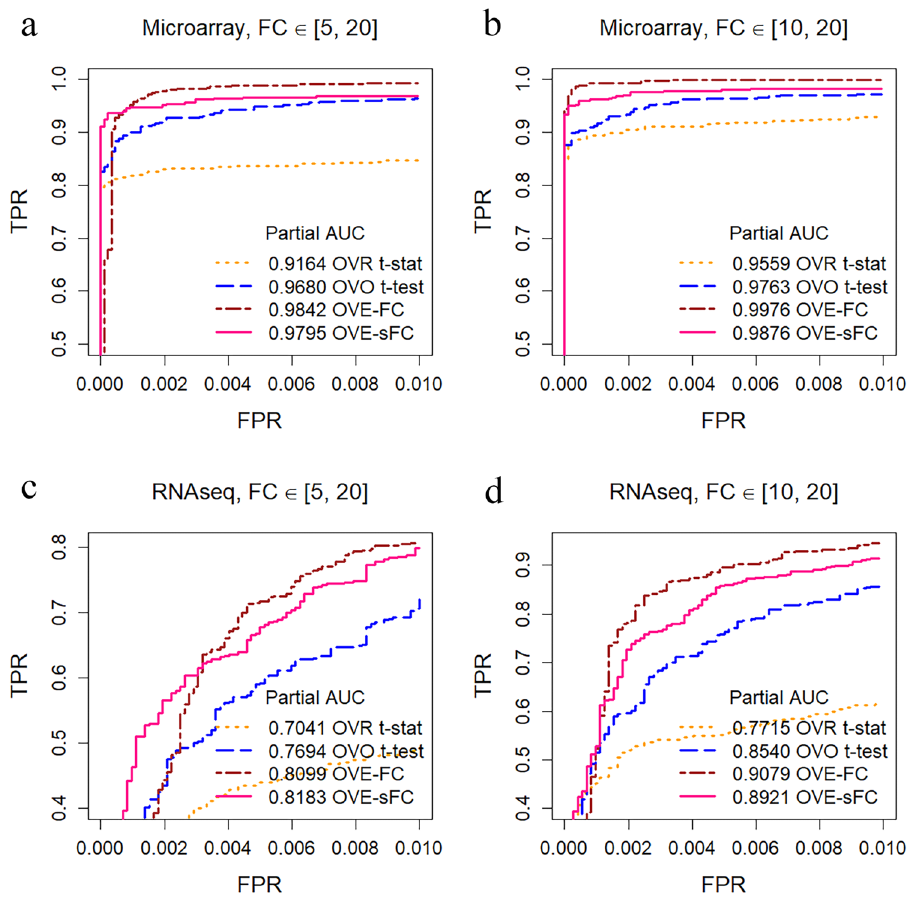
Figure 4. Comparative assessment on detection power (partial ROC curves, FPR < 0.01) using simulations produced from real gene expression data (non-SDEG pattern distribution is consistent with the baseline real dataset under null hypothesis; variances are sampled from real microarray data GSE28490 or RNAseq data GSE60424 with keeping mean–variance trend) involving seven unbalanced subtypes with various parameter settings. SDEGs are adjusted to exhibiting upregulations with varying fold changes sampled from [5, 20] or [10, 20]. ( a ) and ( b ) Partial ROC curves across different FPR points on microarray-derived data. ( c ) and ( d ) partial ROC curves across different FPR points on RNAseq-derived data. (OVR-FC and OVR t-test are not shown here due to low pAUC; subtype-specific OVE-sFC test’s performance is quite similar to OVE-sFC test; more complete ROC curves can be found in Figure S7; more fold change settings can be found in Figure S8). Both OVE-FC and OVE-sFC achieve a better performance than the other methods. OVE-FC achieve the best performance for ideal SDEGs with extremely large fold change, and OVE-sFC would be the preferred choice for SDEGs with small fold change or low SNR (RNASeq data is noiser than microarray data).